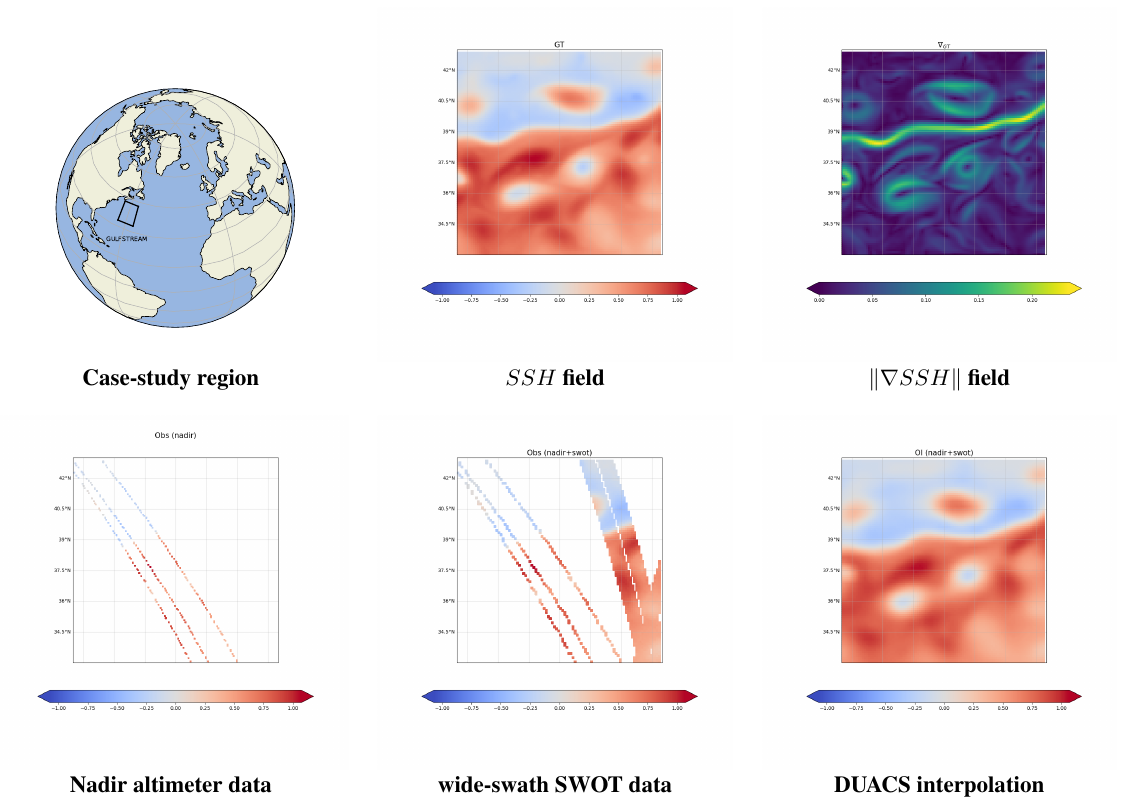
Figure 2. Considered OSSE case-study on satellite-derived sea surface altimetry: we implement an Observing System Simulation Experiment (OSSE) for a case-study region along the Gulf Stream (top, left). We also depict an example of SSH (Sea Surface Height) field (top center), of its gradient norm (top right), of the associated irregular-sampling observation data for nadir altimeters (bottom left) and the upcoming SWOT wide-swath altimeter (bottom right), and of the corresponding gap-free DUACS interpolation using all altimeter data (bottom